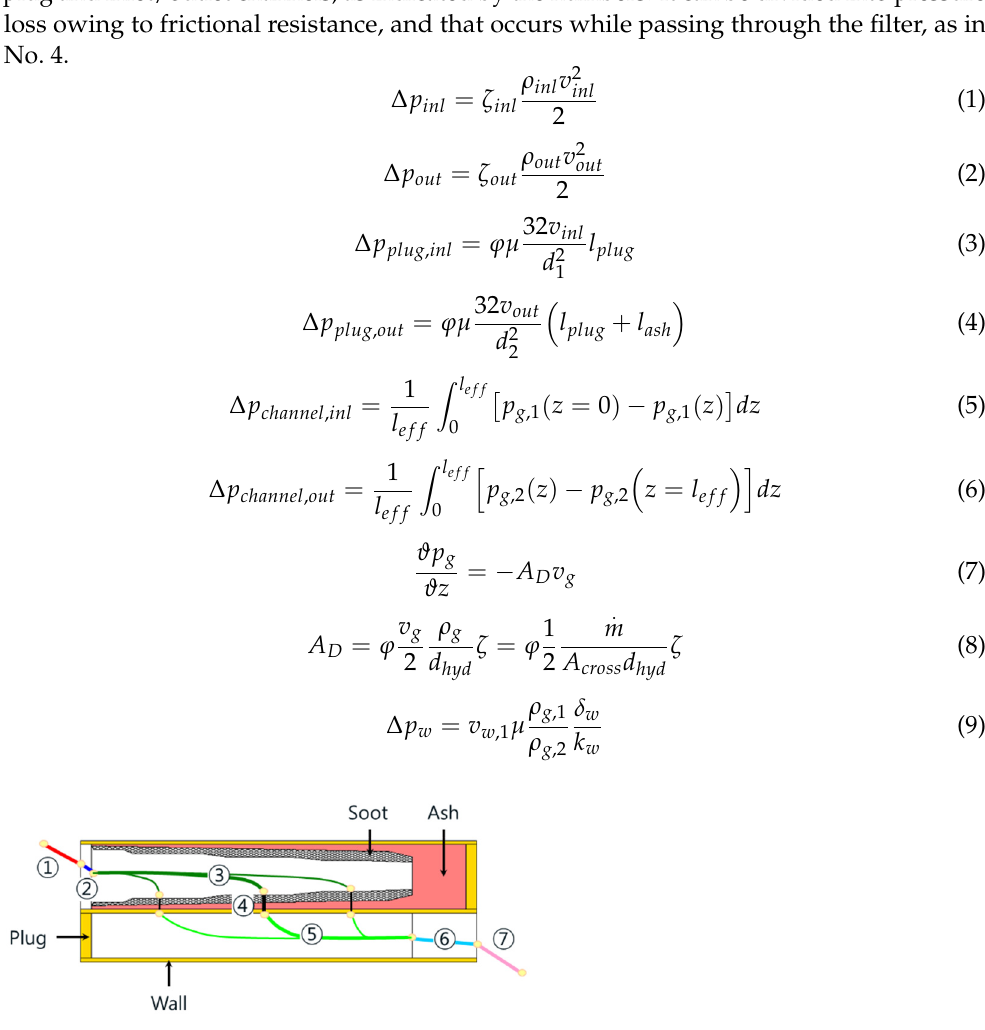
Figure 6. Schematic diagram of structure of pressure change.